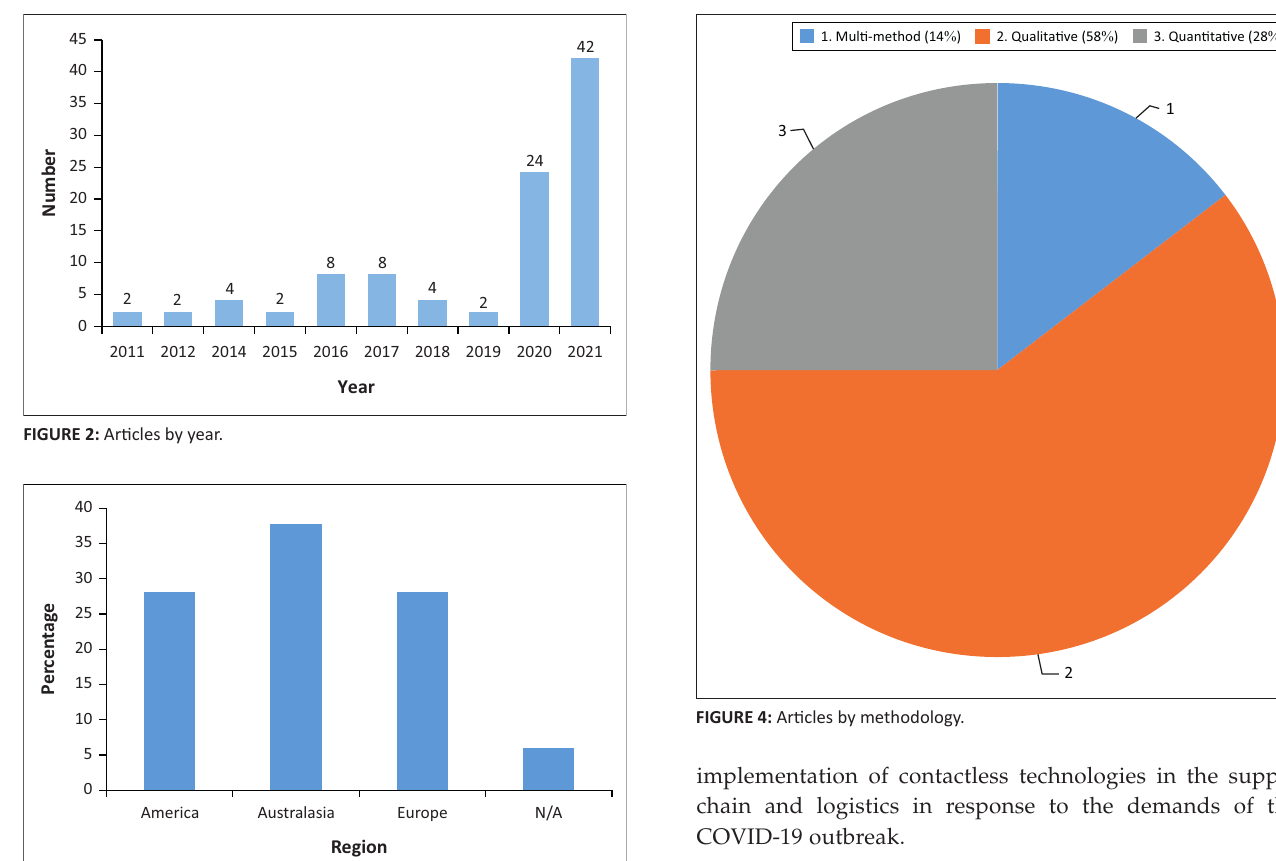
FIGURE 3: Articles by region.